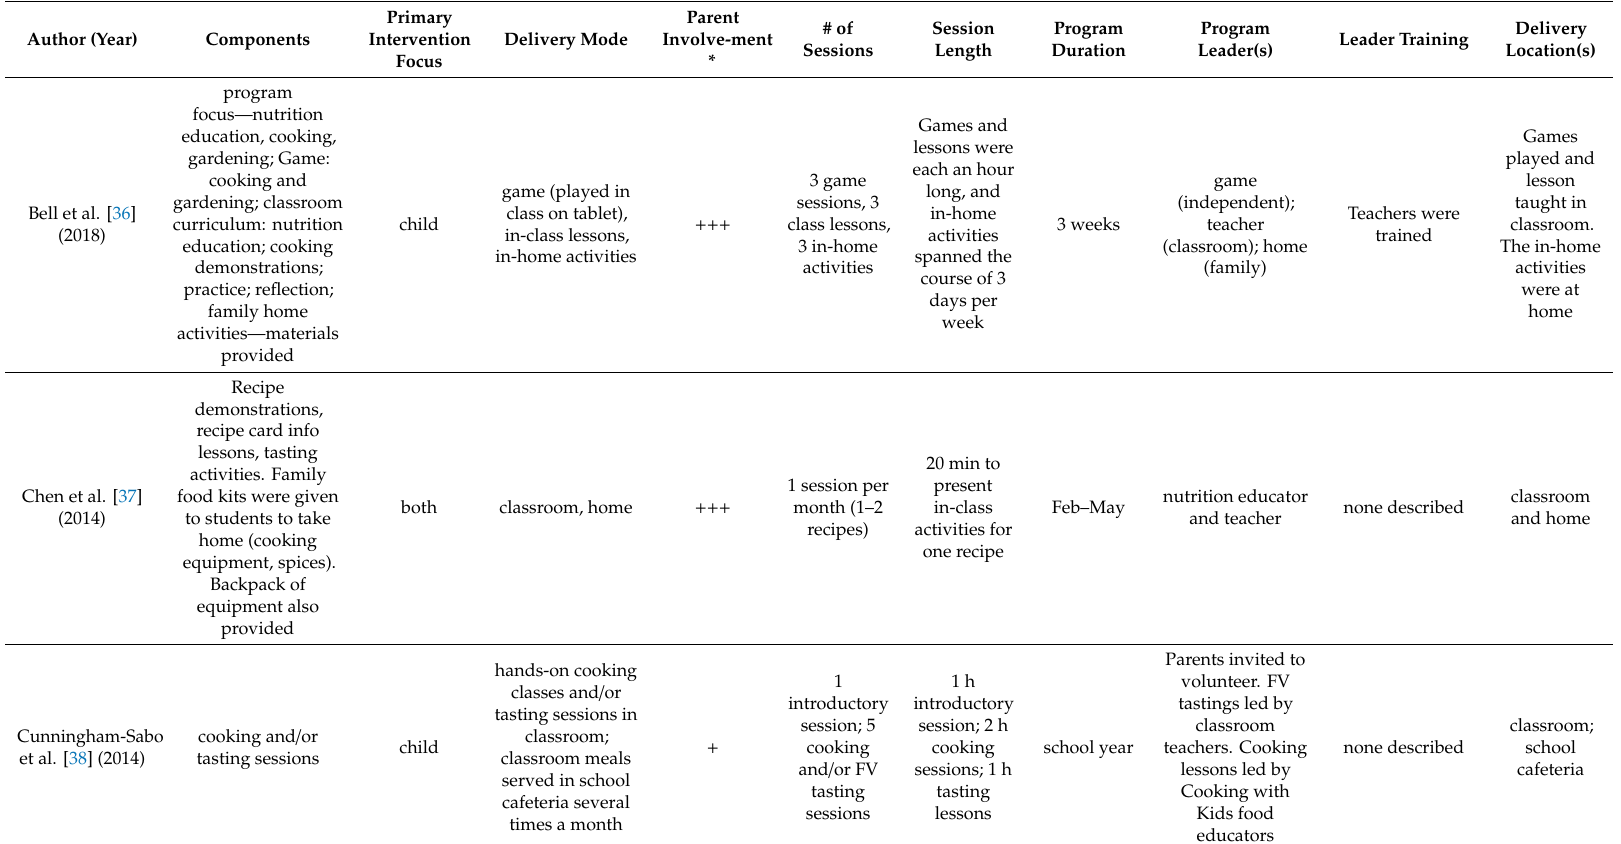
Table 3. Intervention